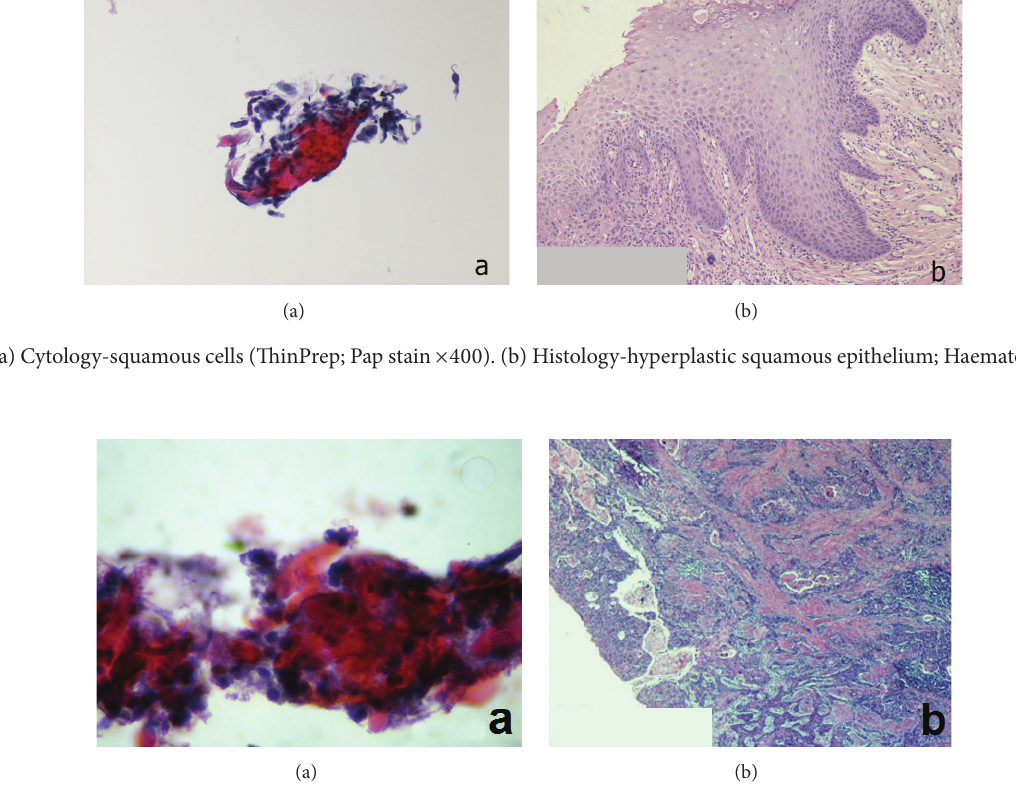
Figure 2: (a) Cytology-mild dysplasia (ThinPrep; Pap stain × 400). (b) Laryngeal mucosa with infiltrated chromium by squamous cell carcinoma of moderate differentiation. Cellular and nuclear polymorphia and increased number of mitoses; Haematoxylin & Eosin × 40.